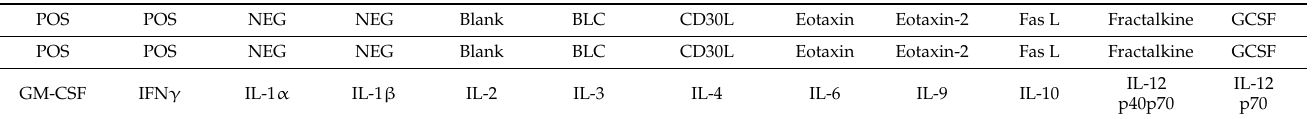
Table 1. Membrane cytokines array